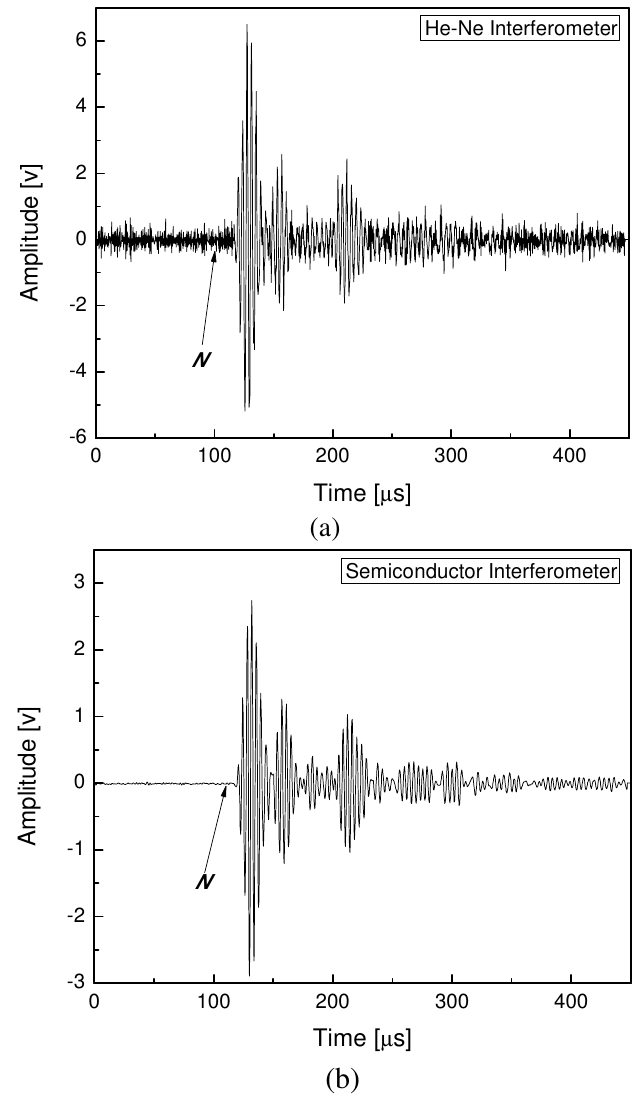
Figure 3. Original guided ultrasonic wave signals acquired using (a) the He-Ne-laser-based interferometer and (b) the infrared-semiconductor-laser-based